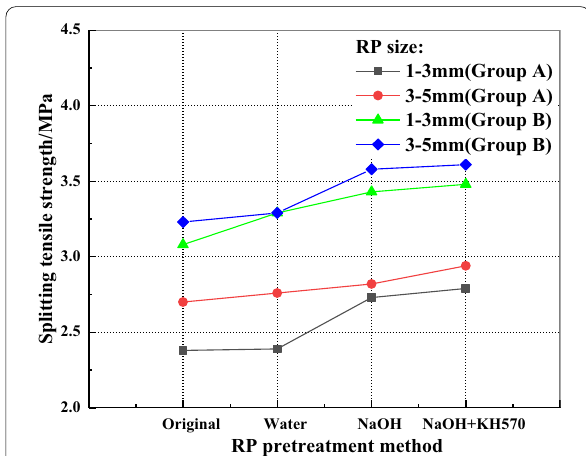
Fig. 12 Effect of different RP pretreatment methods on the compressive strength